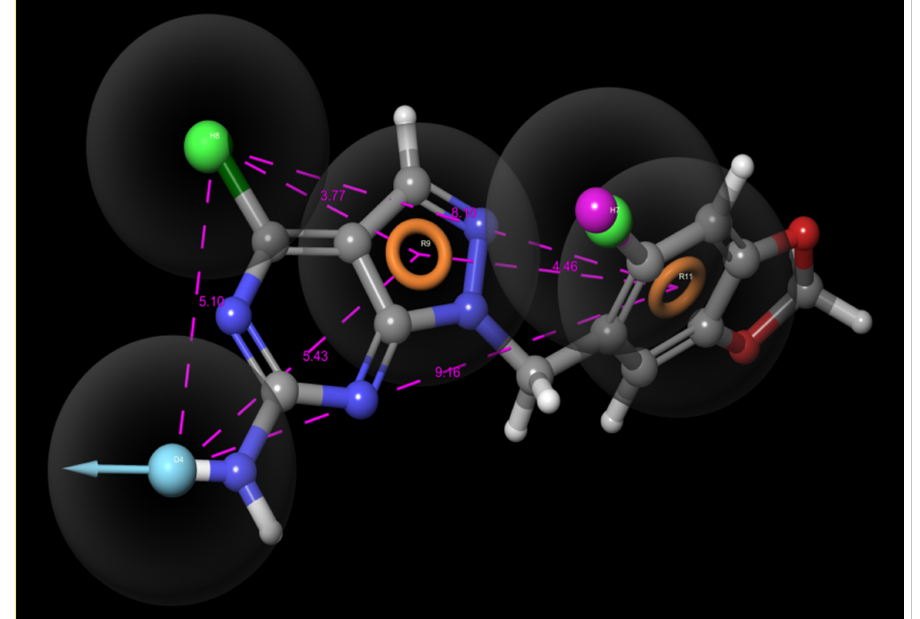
Figure 3. The best common pharmacophoric